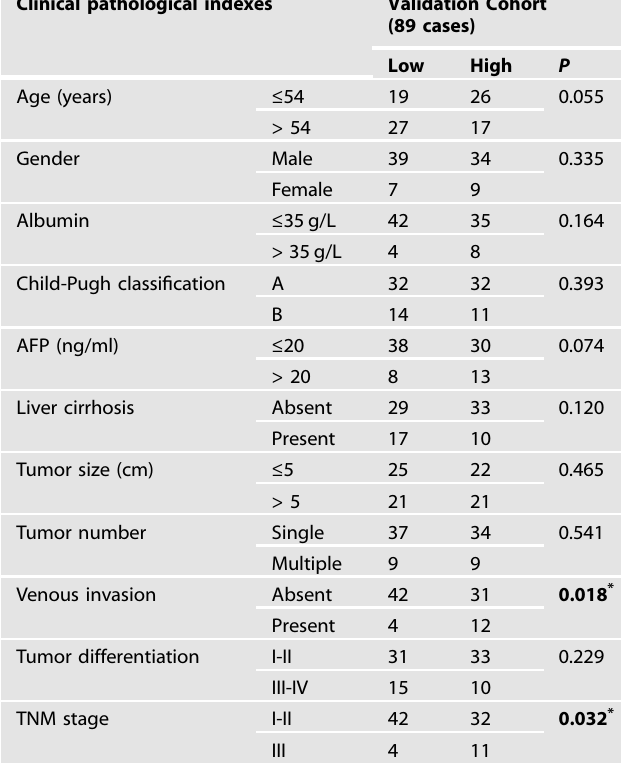
Table 1. Relationship between TINCR expression and the clinical pathological indexes of HCC.